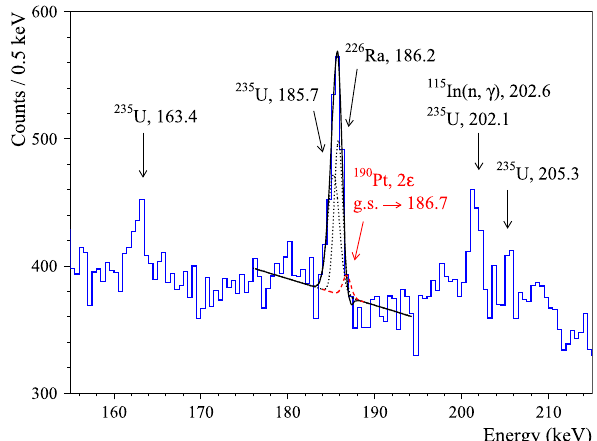
Fig. 6 The energy spectrum gathered with the Pt sample in the vicinity of γ peak 186.7 keV expected in the 2 ε decay of 190 Pt to the 2 + 186.7 keV excited level of 190 Os. The fit of the data is shown by solid line, while the excluded peak is presented by dashed line. The dotted lines show the peaks of 235 U and 226 Ra included in the background model. The energies of the background and expected γ peaks are in keV